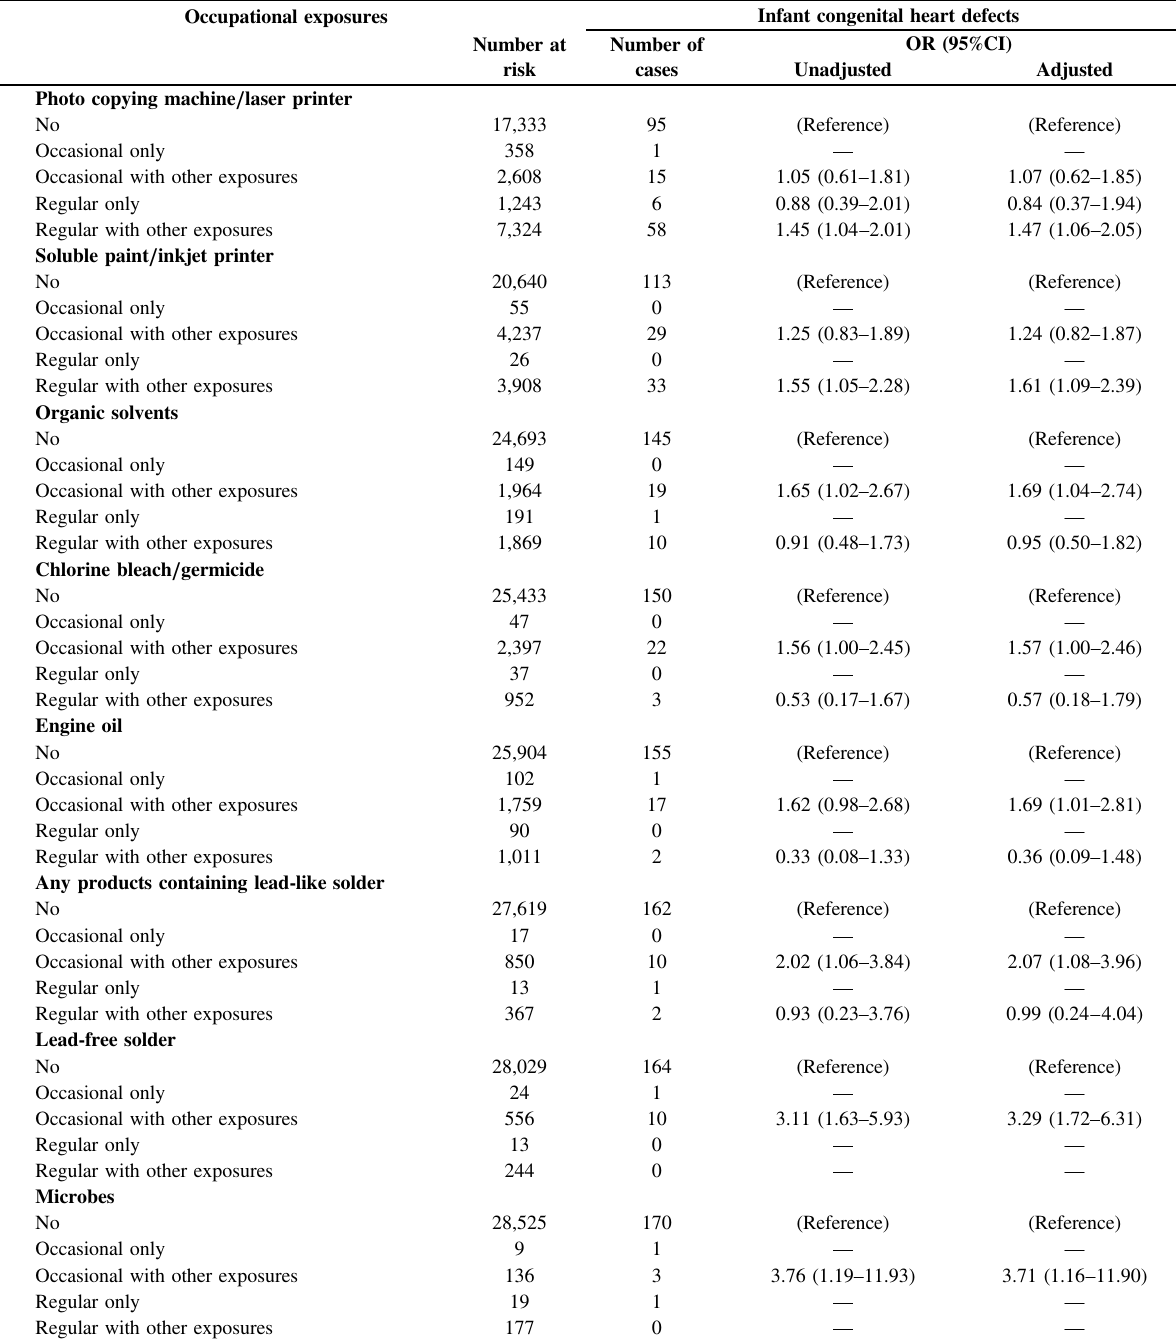
Table 3 Associations between paternal combined occupational exposures and the risk of infant congenital heart